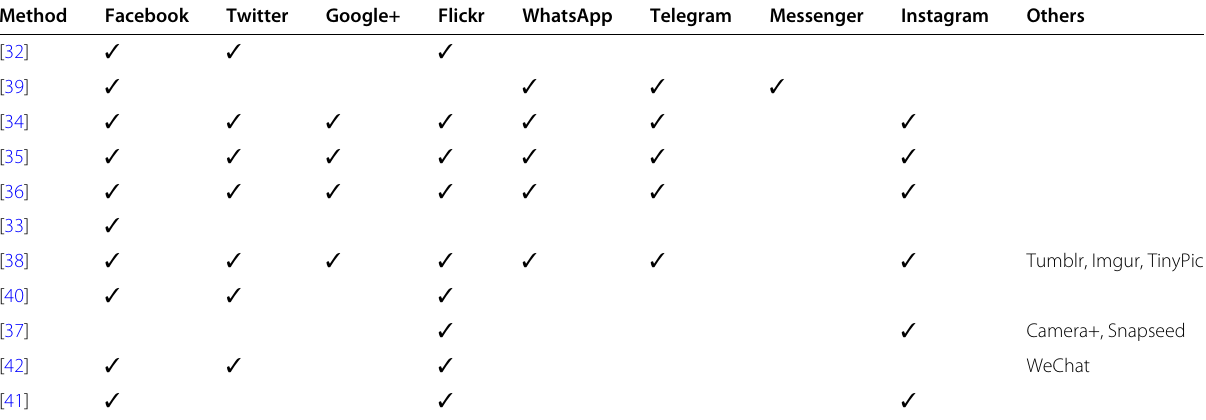
Table 5 Summary of social media and web platforms analyzed in different studies Method